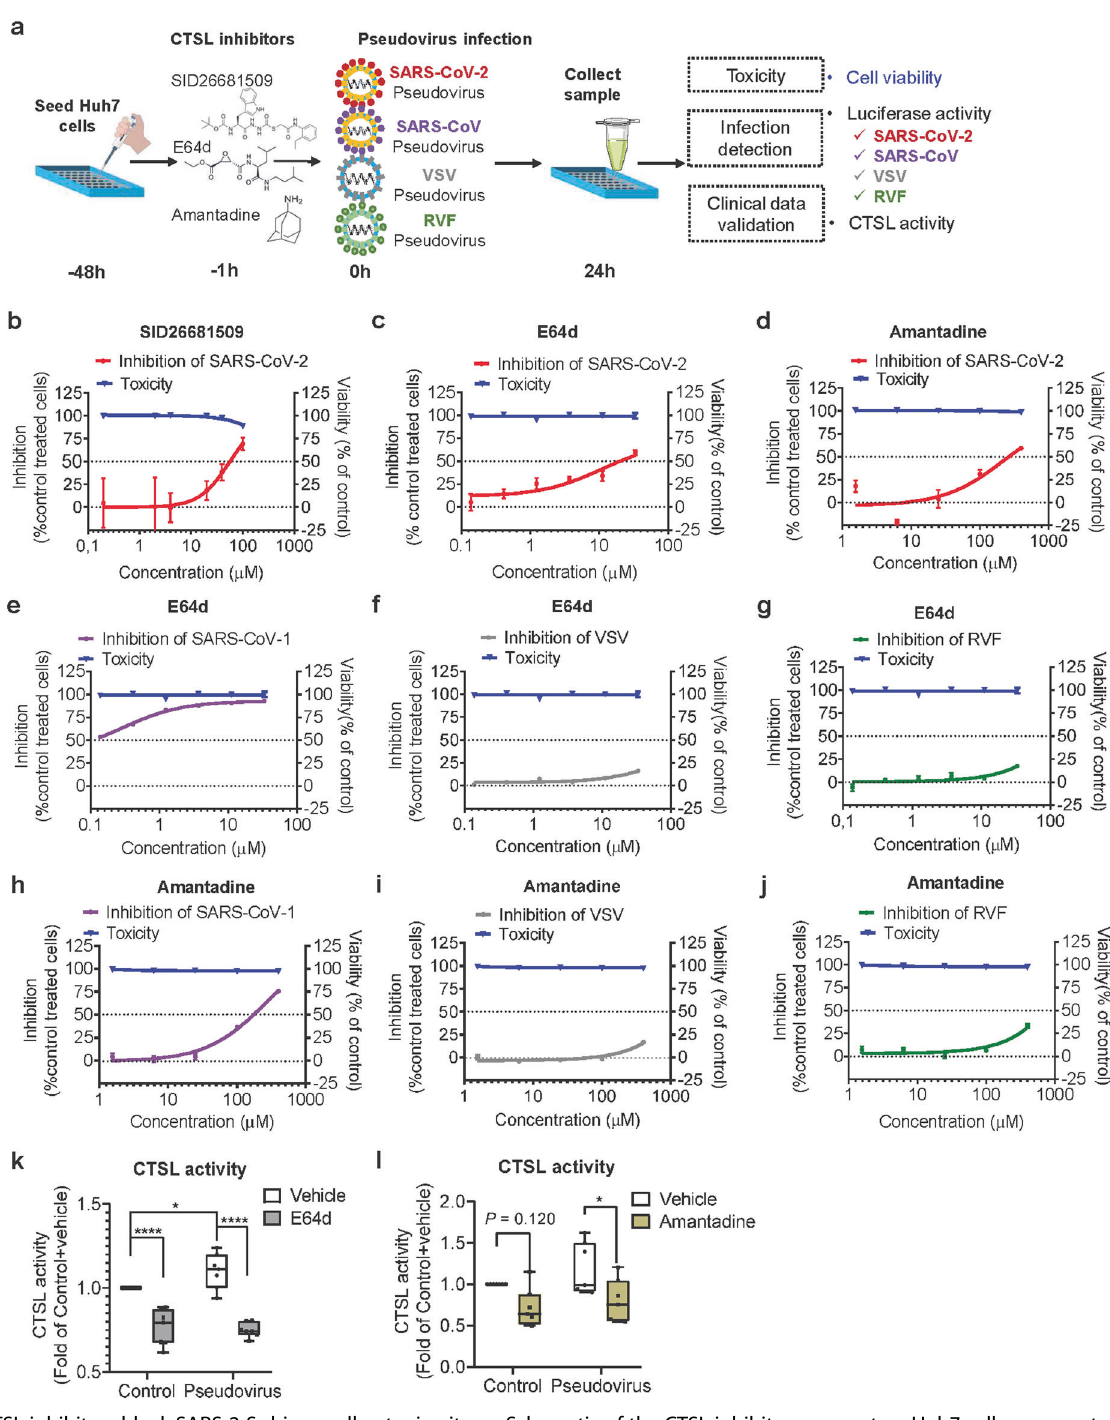
Fig. 5 CTSL inhibitors block SARS-2-S-driven cell entry in vitro. a Schematic of the CTSL inhibitor assay setup. Huh7 cells were pretreated with different drugs 1 h before infection with different pseudoviruses, as indicated, at the same dose (1.3 × 10 4 TCID 50 /ml). Pseudovirus infection and cell viability were evaluated by luciferase activity and MTT assay, respectively. b – d Inhibition of SARS-2-S-driven cell entry by different doses of SID 26681509 ( b ), E64d ( c ), and amantadine ( d ) and viability of cells treated with different doses of the drugs as indicated. n = 4. e – g Effects of E64d on SARS-CoV-1 pseudovirus ( e ), VSV pseudovirus ( f ), and RVF pseudovirus ( g ) infection and viability of cells treated with different doses of E64d as indicated. n = 4. h – j Effects of amantadine on SARS-CoV-1 pseudovirus ( h ), VSV pseudovirus ( i ), and RVF pseudovirus ( j ) infection and viability of cells treated with different doses of amantadine as indicated. n = 4. k , l Effects of drug pretreatment on CTSL enzyme activity in Huh7 cells with or without pseudovirus infection. Huh7 cells were pretreated with vehicle, 30 μ M E64d ( k ) or 300 μ M amantadine ( l ) for 1 h and were then infected with SARS-CoV-2 pseudovirus at a dose of 1.3 × 10 4 TCID 50 /ml. Cells not infected with pseudovirus were used as controls. n = 7. Statistical signi fi cance was assessed by two-way ANOVA with the Holm – Sidak post hoc test for multiple comparisons. The data are expressed as the mean ± s.e.m. values. * P < 0.05, ** P < 0.01, *** P < 0.001, **** P < 0.0001